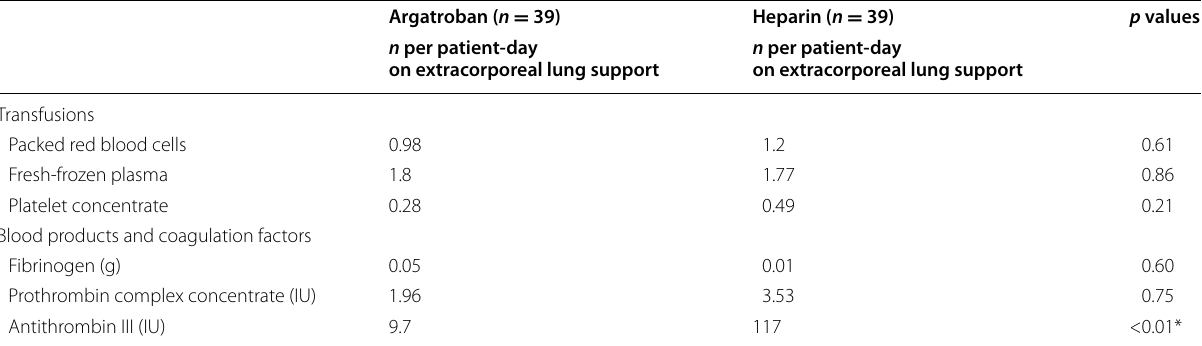
Table 3 Transfusions and blood products and of ARDS patients on ECMO/pECLA with either argatroban or heparin